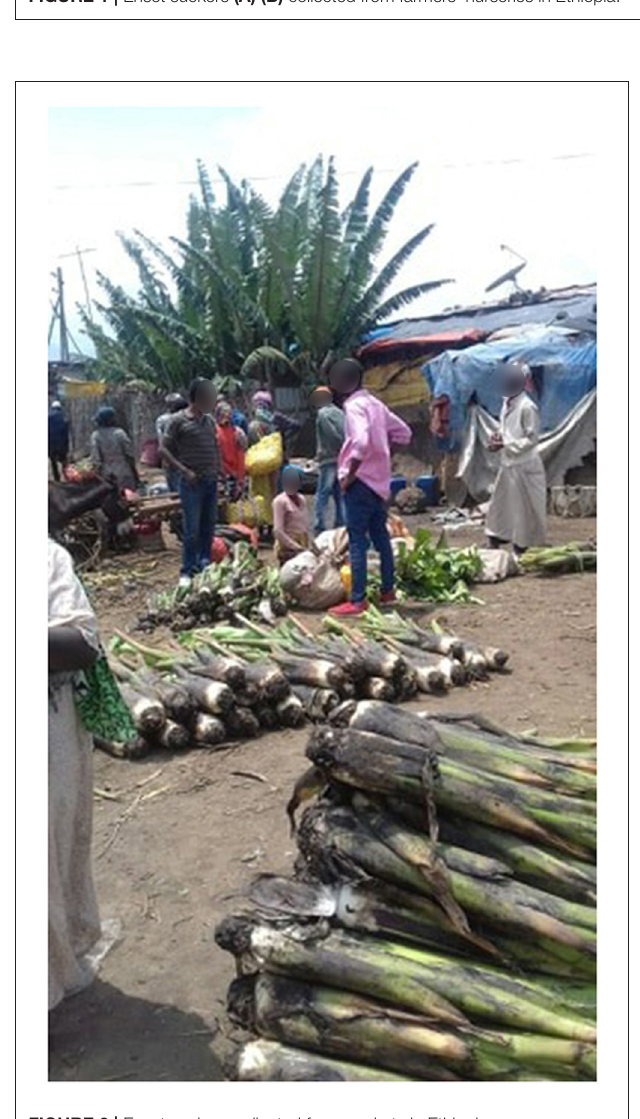
transformation so that the data conformed to normal distribution (Zuur et al., 2010). The association between nematode density and altitude was analyzed using Pearson’s correlation